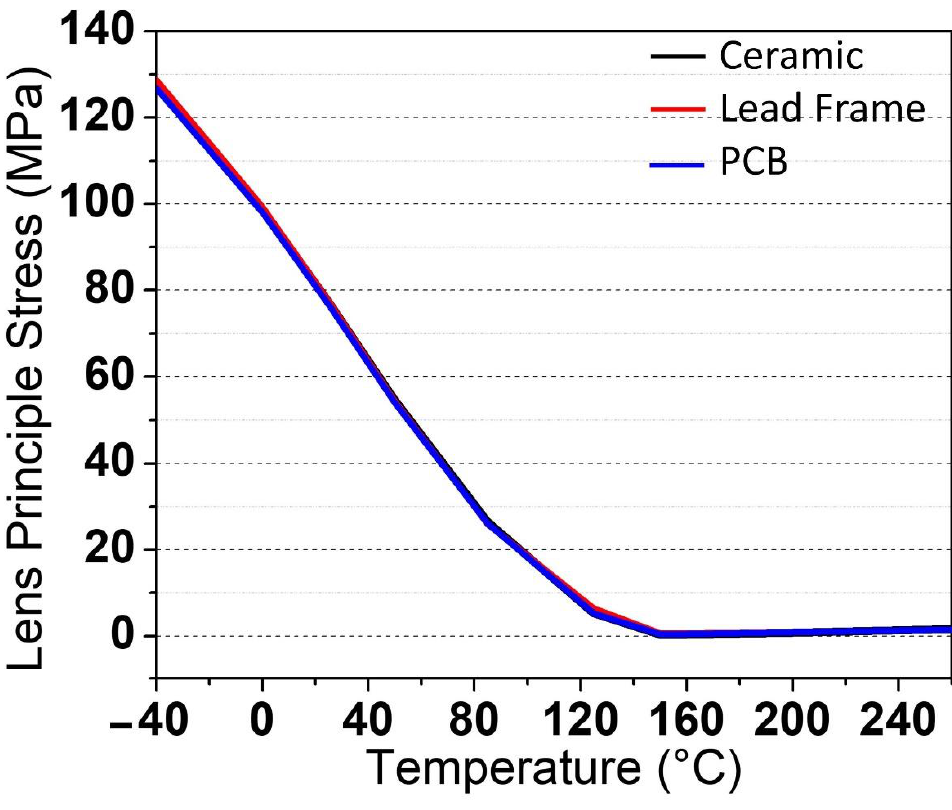
Figure 13. Stress values of lens versus temperatures ranging from − 40 °C to 260 °C during the mechanical stress simulation.